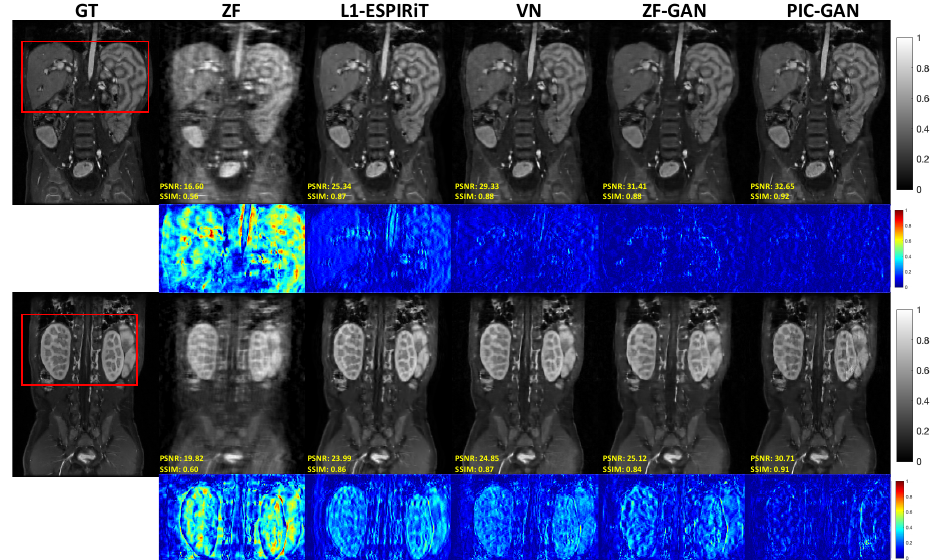
Figure 3. Representative abdominal images reconstructed with acceleration AF = 6. The first and second rows depict reconstruction results for regular Cartesian sampling, the third and fourth row depict the same for variable density random sampling. The PIC-GAN reconstruction shows reduced artifacts compared to other methods. (GT: Ground truth. ZF: Zero-filled. L1-ESPIRiT: Sparsity-based parallel imaging. VN: Variational network. ZF-GAN: Conventional GAN with single-channel images as input PIC-GAN: Our proposed method. Red box: Zoomed-in